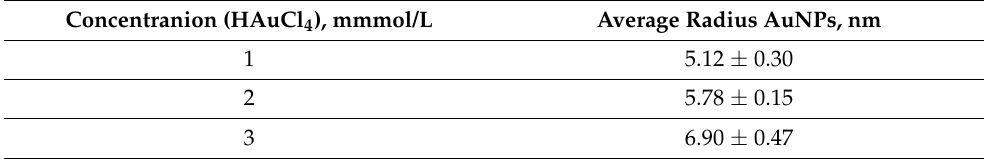
Table 2. Dependence of the size of gold nanoparticles on the concentration of tetrachloroauric